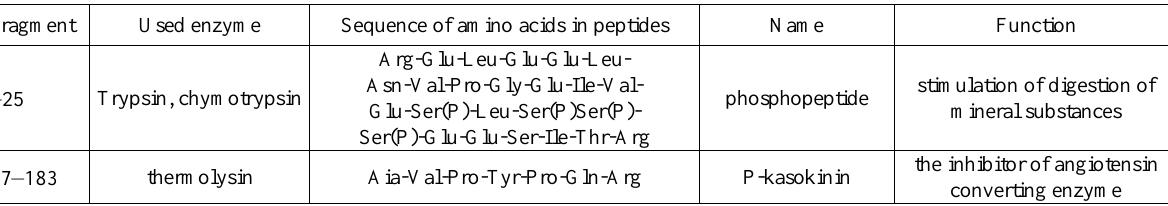
Table 7. Peptides identified in the studied